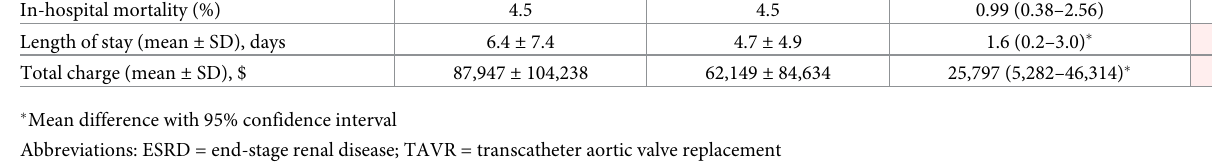
Table 3. Comparison of outcomes in 90-day readmissions after TAVR in patients with and without ESRD. ESRD (+) ESRD (-) P